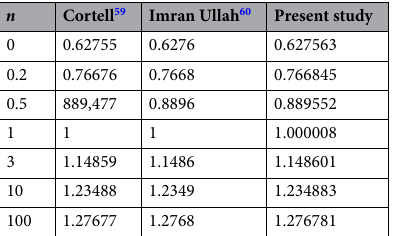
( 0 ) for increasing Pr when β = M = ξ = Rd = Pr = N b = N t = f Table 2. The numerical results of − ′′ (cid:31) (cid:31) 1 0, Bi 1 α 1 δ χ Le k 1 N Ec E m B r = = = = = = = = = = = =